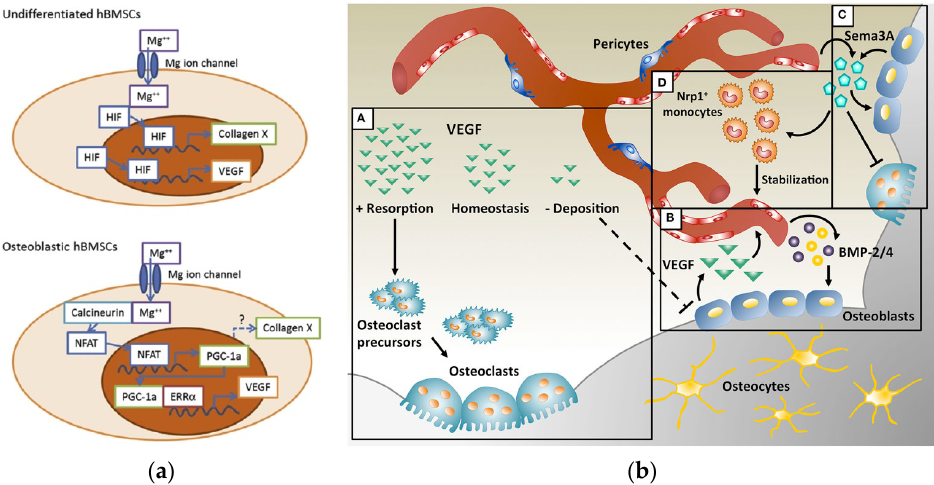
Figure 1. ( a ) Schematic diagram of the putative intracellular signaling cascades upon stimulation of hBMSC with magnesium ions. The addition of a magnesium cation causes an increase in the intracellular Mg ion concentration in undifferentiated BMSCs. The HIFs then migrate to the cell nucleus and induce the production of COL10A1 and VEGF. On the other hand, in differentiated BMSCs, the Mg ion activates the production of PGC-1 α (via an unknown transcription factor), which induces the production of VEGF. Adapted with permission from ref. [30]. Copyright 2014, Elsevier. ( b ) Combination of angiogenesis and osteogenesis in intramembranous ossification. ( A ) Physiological levels of VEGF maintain bone homeostasis, whereas too little VEGF interrupts the differentiation of osteoblasts and too much VEGF increases the recruitment of osteoclasts, resulting in bone resorption. ( B ) During bone repair, VEGF is produced by osteoblasts and promotes the migration and proliferation of endothelial cells. In turn, endothelial cells secrete osteogenic factors such as bone morphogenetic protein (BMP)-2 and BMP-4, which support osteoblast differentiation. ( C ) VEGF dose-dependently regulates the expression of the semaphorin class of molecules 3A (Sema3A) in endothelial cells, while Sema3A from various sources inhibits osteoclast differentiation and stimulates bone deposition. ( D ) Sema3A is also responsible for a set of neuropilin-1 (Nrp1 + )-expressing monocytes that contribute to vascular stabilization. Reprinted from ref.